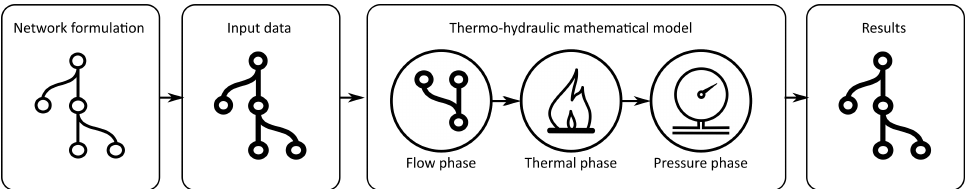
Figure 1. Diagram of a decision support system for the district heating system